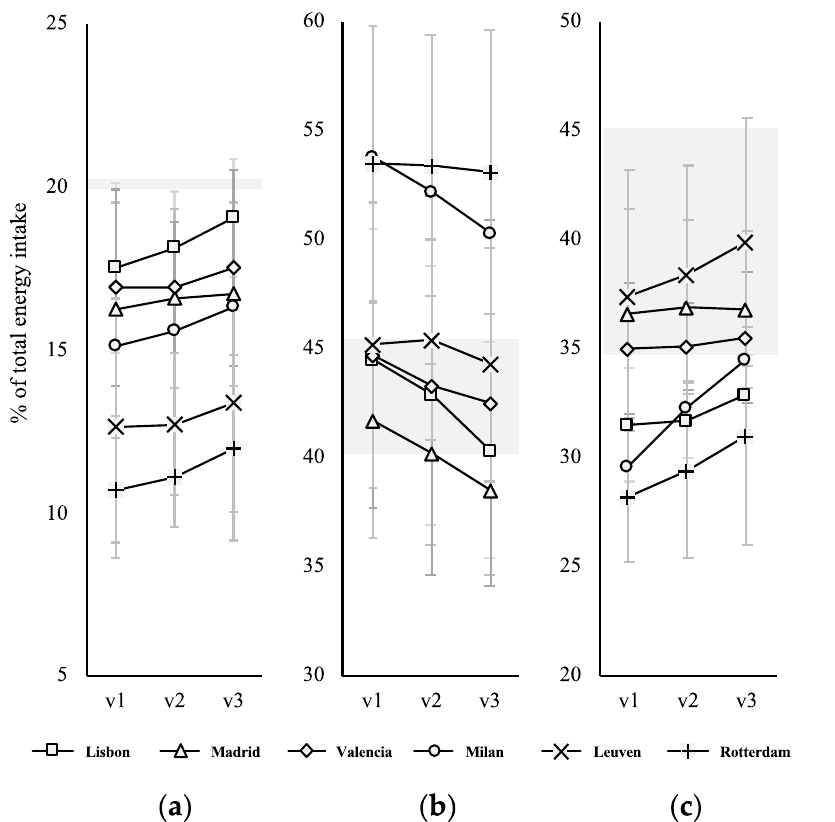
Figure 3. Evolution of macronutrient intake during the 6-months period of use of the self-management mobile app in the six participating European centres: ( a ) protein, ( b ) carbohydrates and ( c ) lipid. Grey areas represent the range of the recommended intake according to Turck et al. (2016) [3].